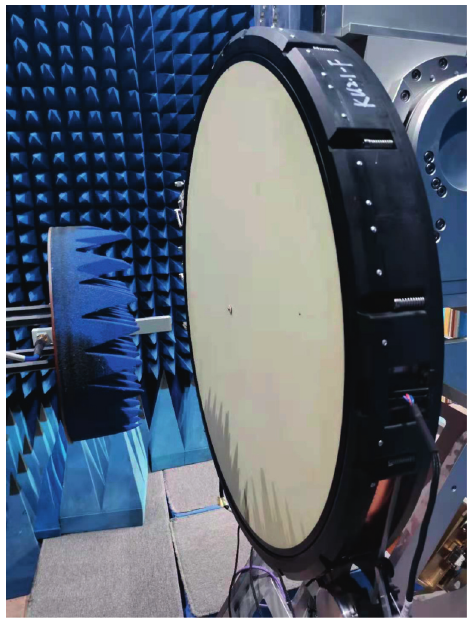
Figure 7: Antenna prototype and measurement